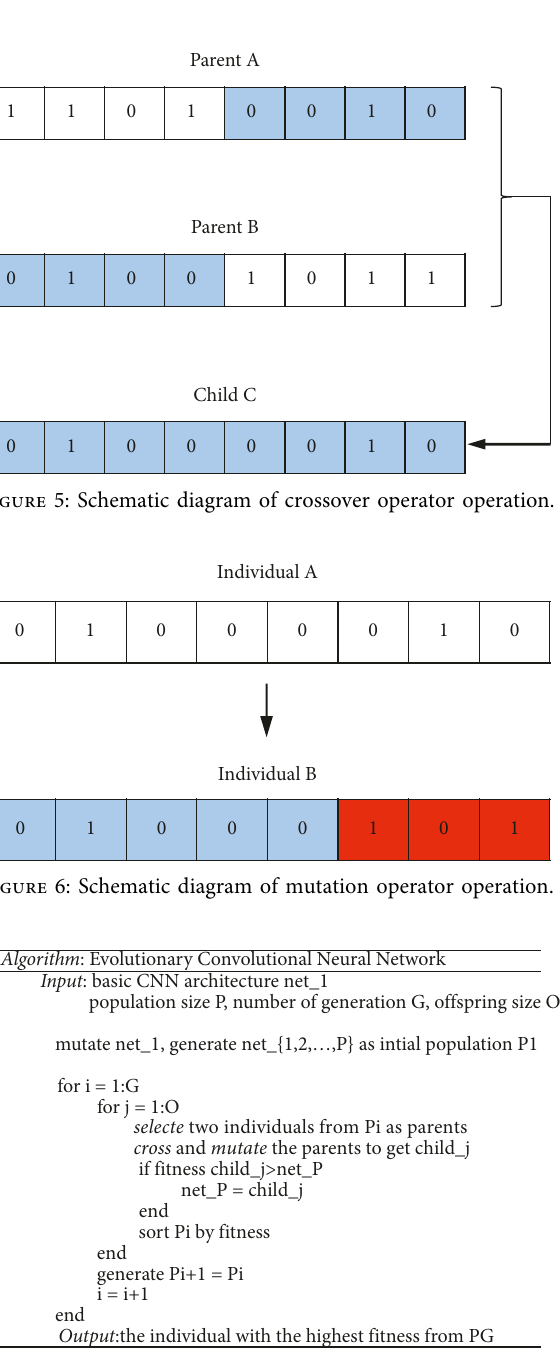
Figure 7: Pseudocode of ECNN.